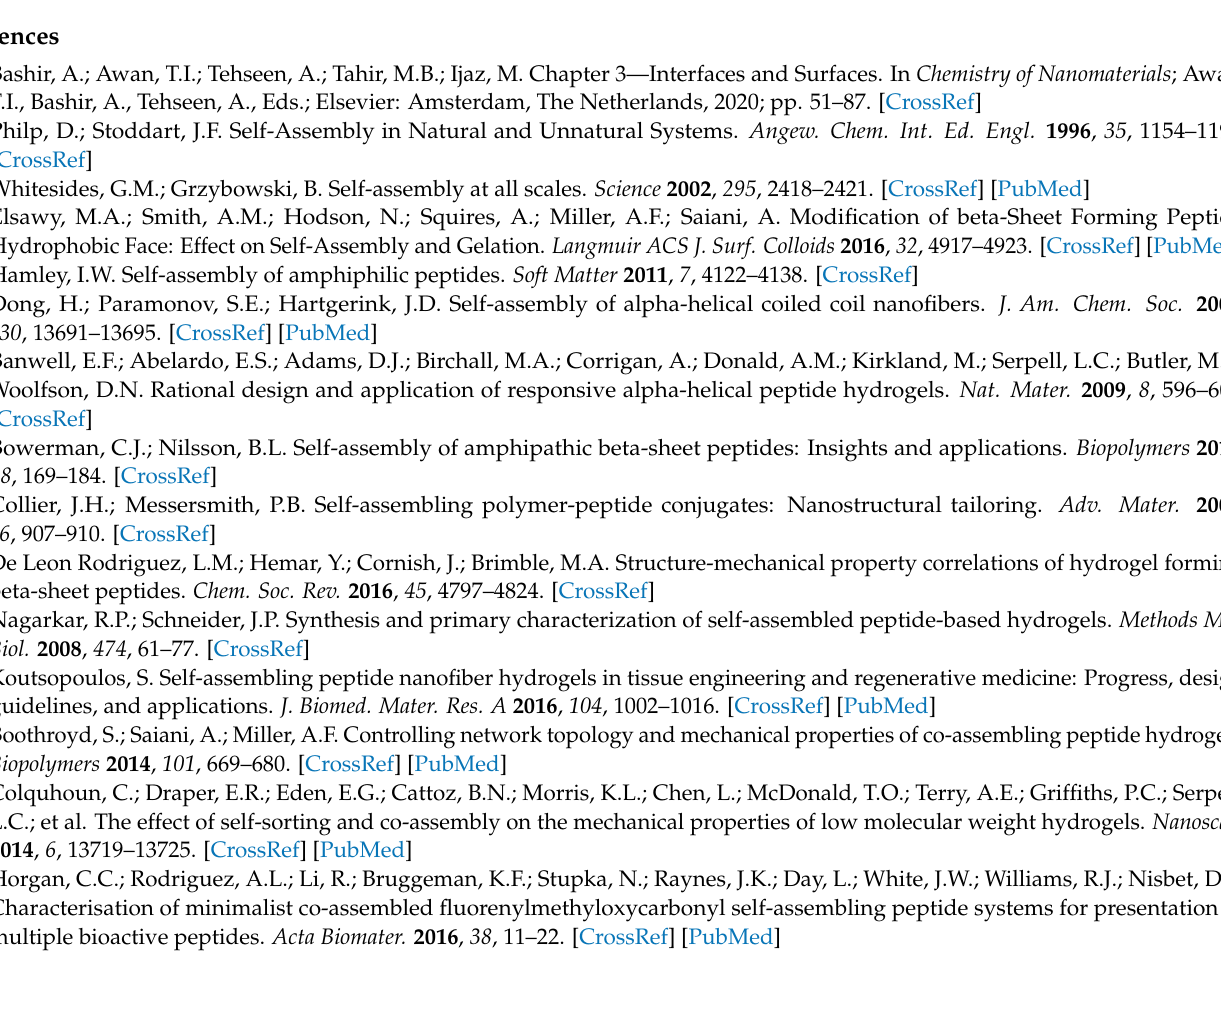
spectra of P5 peptide; Figure S2: Strain amplitude sweep; Figure S3: SEM images of lyophilized hydrogels; Figure S4: TEM image of H3 hydrogel; Figure S5: Rheology of hydrogels of P5 2% ( w / v ) with different concentrations of P21; Figure S6: Rheology of H1 and H2 in 10% AcOH; Figure S7: AFM images of hydrogels formed by P5 at 1% ( w / v ) in 10% AcOH ( w / v ); Figure S8: SEM image of FF nanotubes and HF4 hydrogel formed by P5 at 1% ( w / v ) and FF nanotubes at 0.25% ( w / v ); Figure S9: (a) 1 H-NMR spectrum of P5 recorded in dmso-d 6 at 298 K; (b) HRESI-MS spectrum of P5; Figure S10: (a) 1 H-NMR spectrum of P21 recorded in dmso-d 6 at 298 K; (b) ESI-MS spectrum of P21; Figure S11: (a) 1 H-NMR spectrum of FF recorded in dmso-d 6 at 298 K; (b) ESI-MS spectrum of